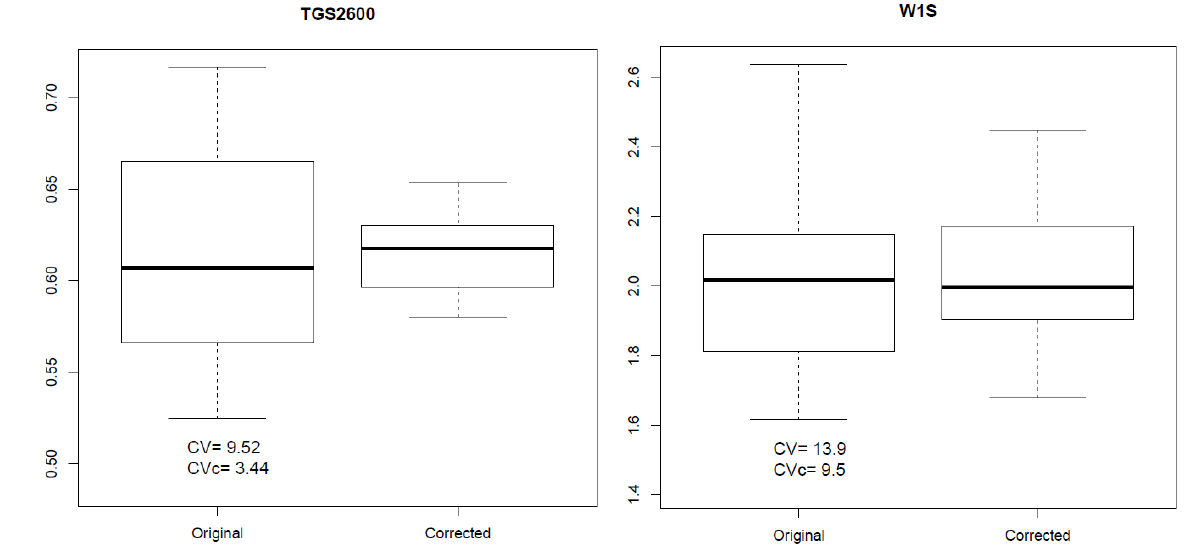
Figure 8. Boxplot of the distributions of the values of AVR of Figure 5 (original) and its normalized values